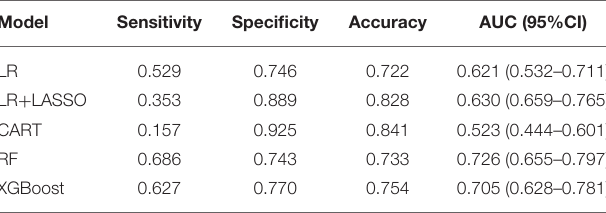
TABLE 4 | Detailed performance metrics for the five models in external validation.